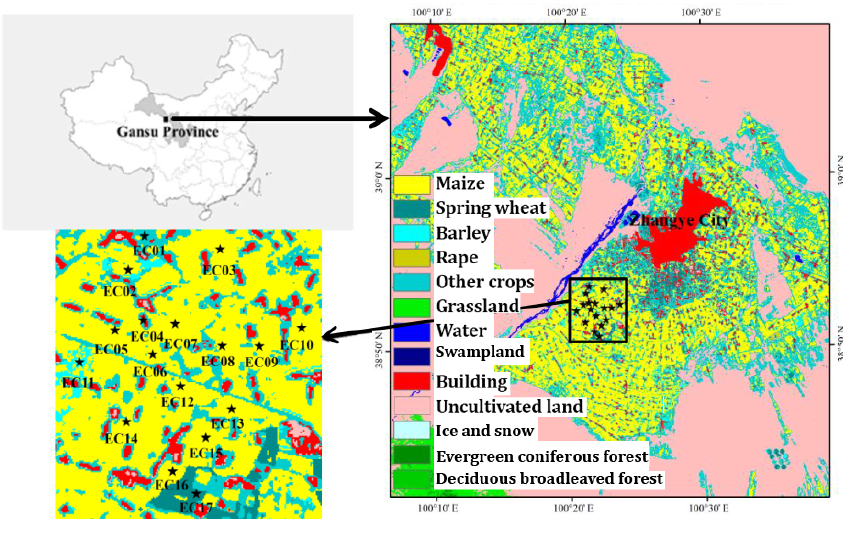
Figure 3. Distribution of in situ stations and land use classifications in our study area (revised based on Peng et al., 2016).